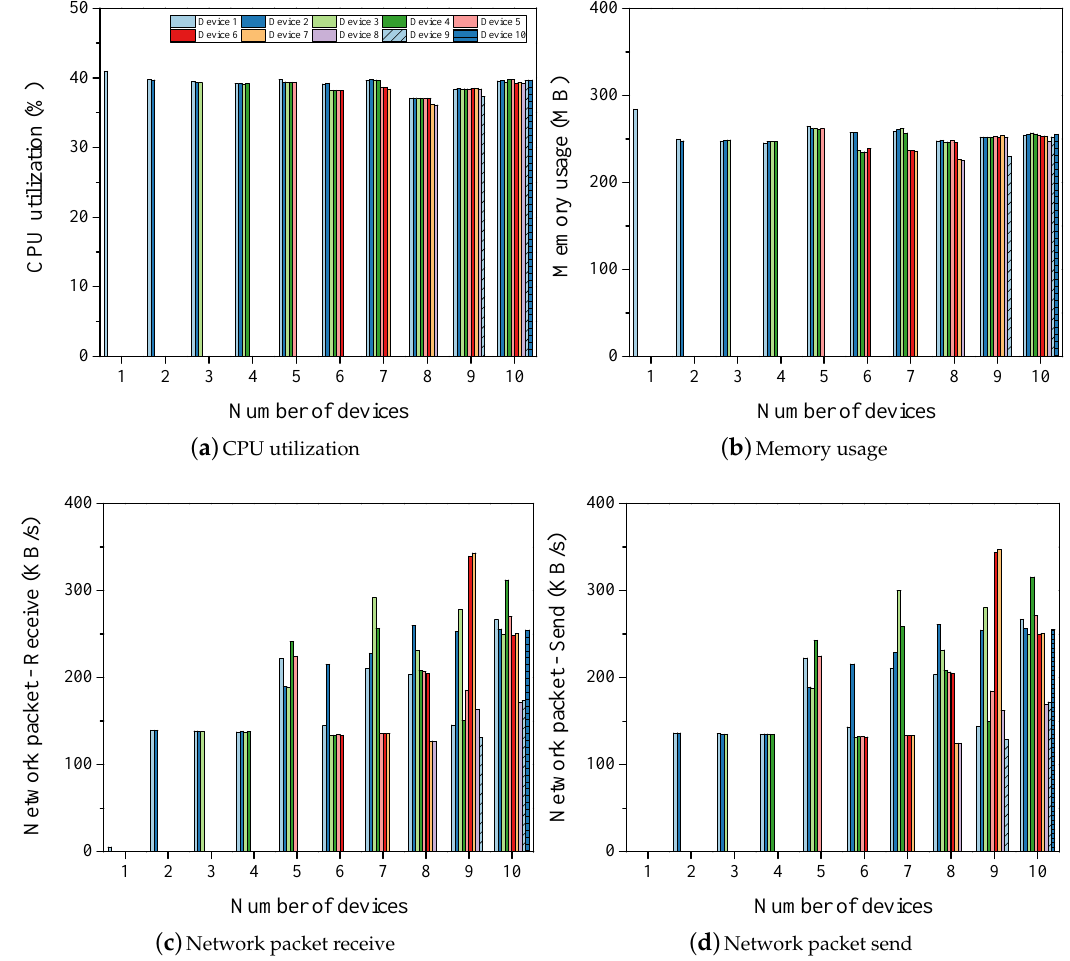
Figure 6. Hardware resources for training ResNet 32 ×